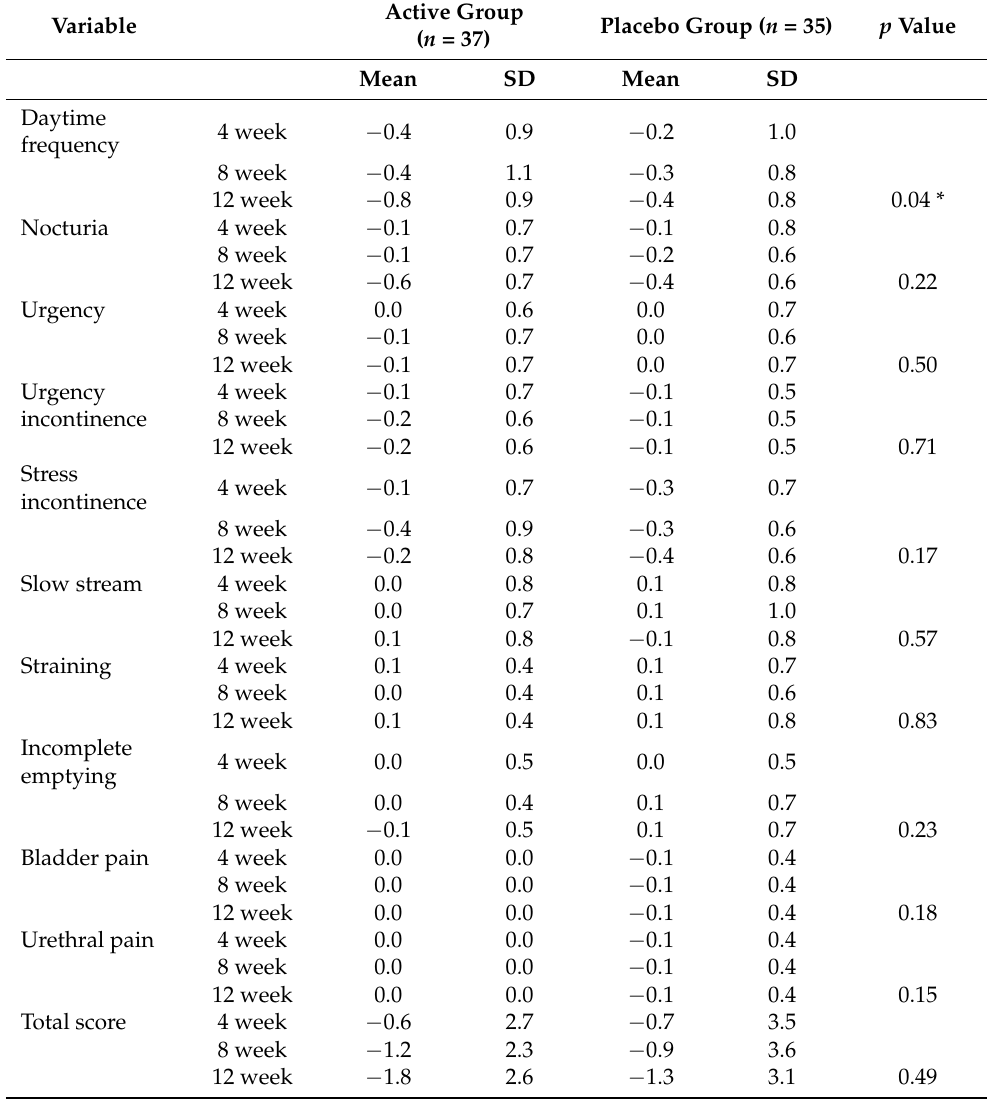
Table 2. Mean difference from the baseline for core lower urinary tract symptom scores (CLSS) in SPE treatment (active) and placebo